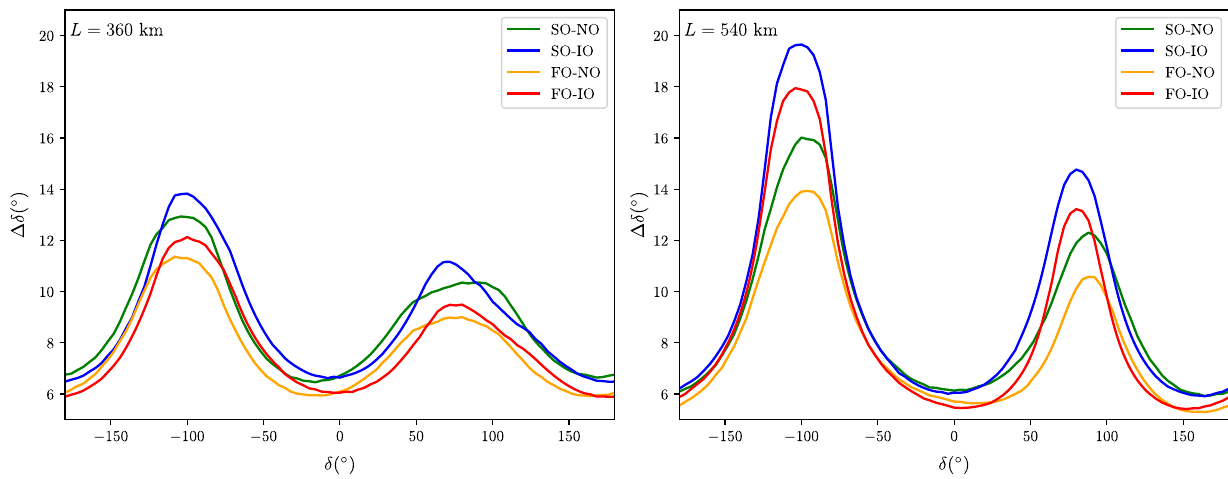
Fig. 9 Precision on the measurement of δ for a total running time of 10 years when the relative running time in neutrino and antineutrino modes is optimized for each value of δ . This corresponds to running